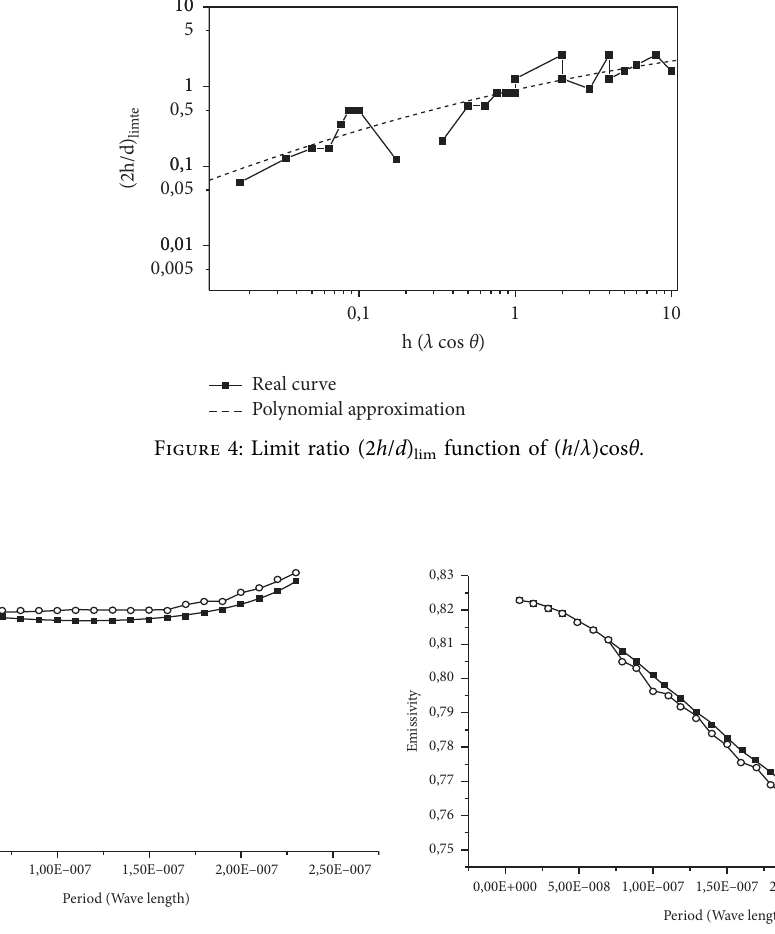
Figure 5: Emissivity following the normal of a sinusoidal grating, determined by MD, compared with that determined by the homog- enization process: (a) case of gold; (b) case of tungsten.